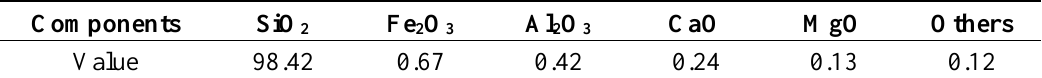
Table 3. Components of the silica (wt%).